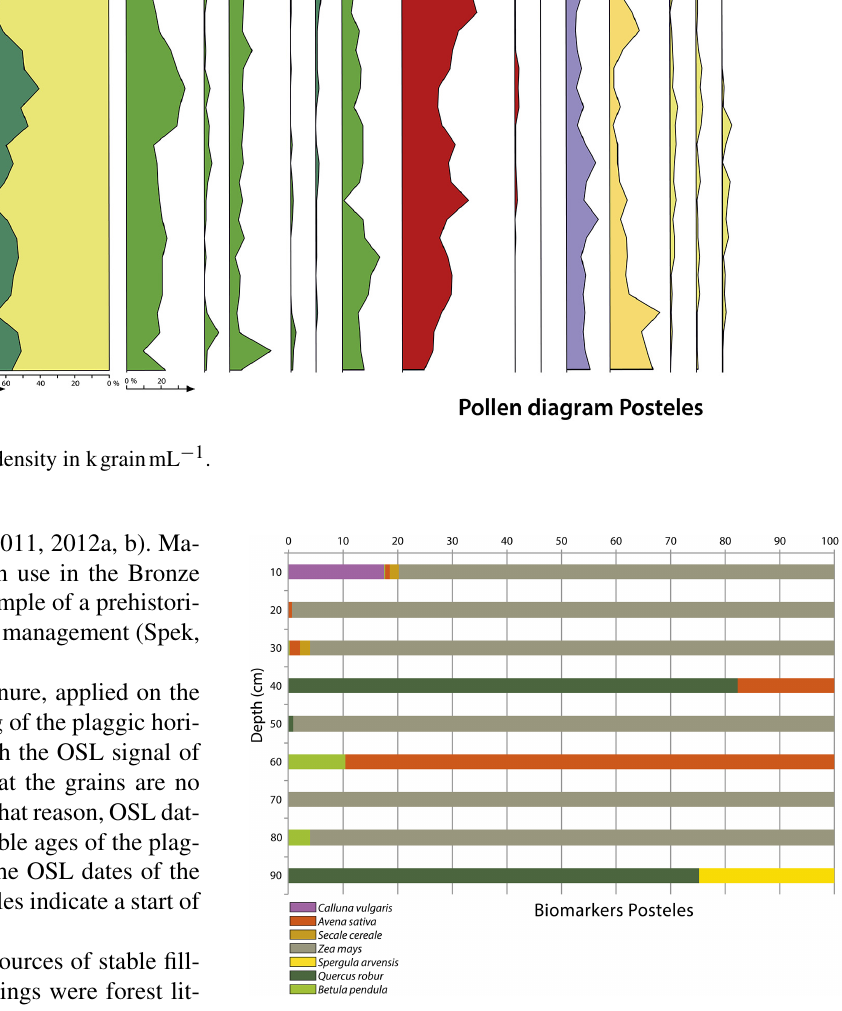
Figure 13. Biomarker diagram